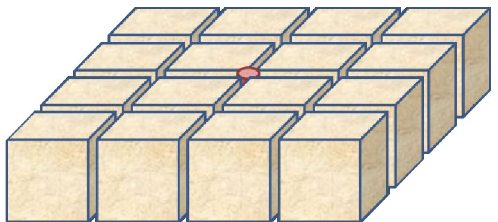
Figure 10: Fracture network model of volumetric fracturing near the wellbore.